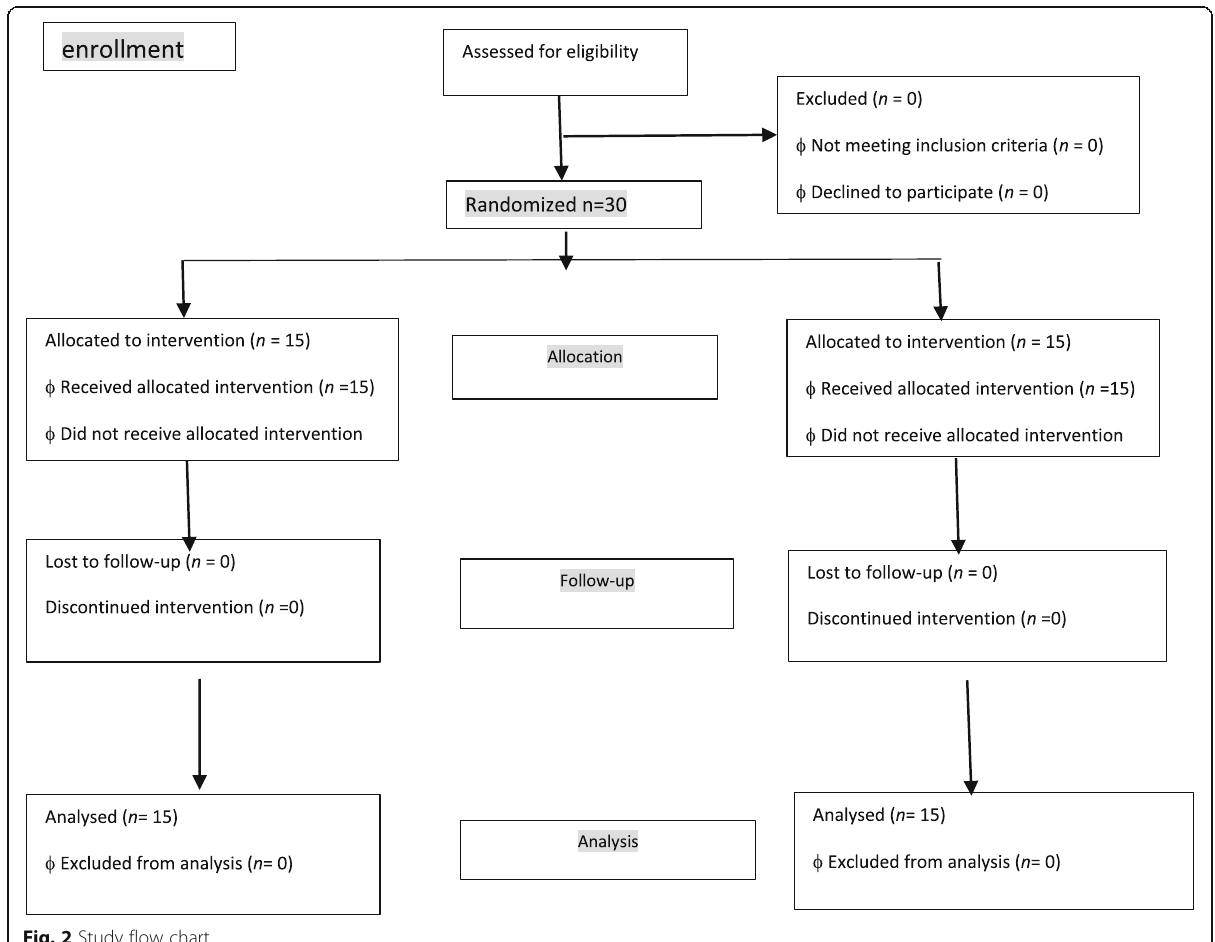
Table 1 Descriptive analysis of the demographic and surgical data in each group Variable Group Q